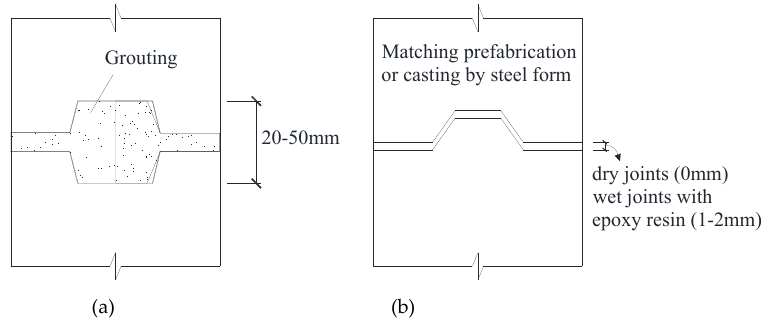
Figure 1. Types of joints of precast components: ( a ) Closed joints; ( b ) open joints.